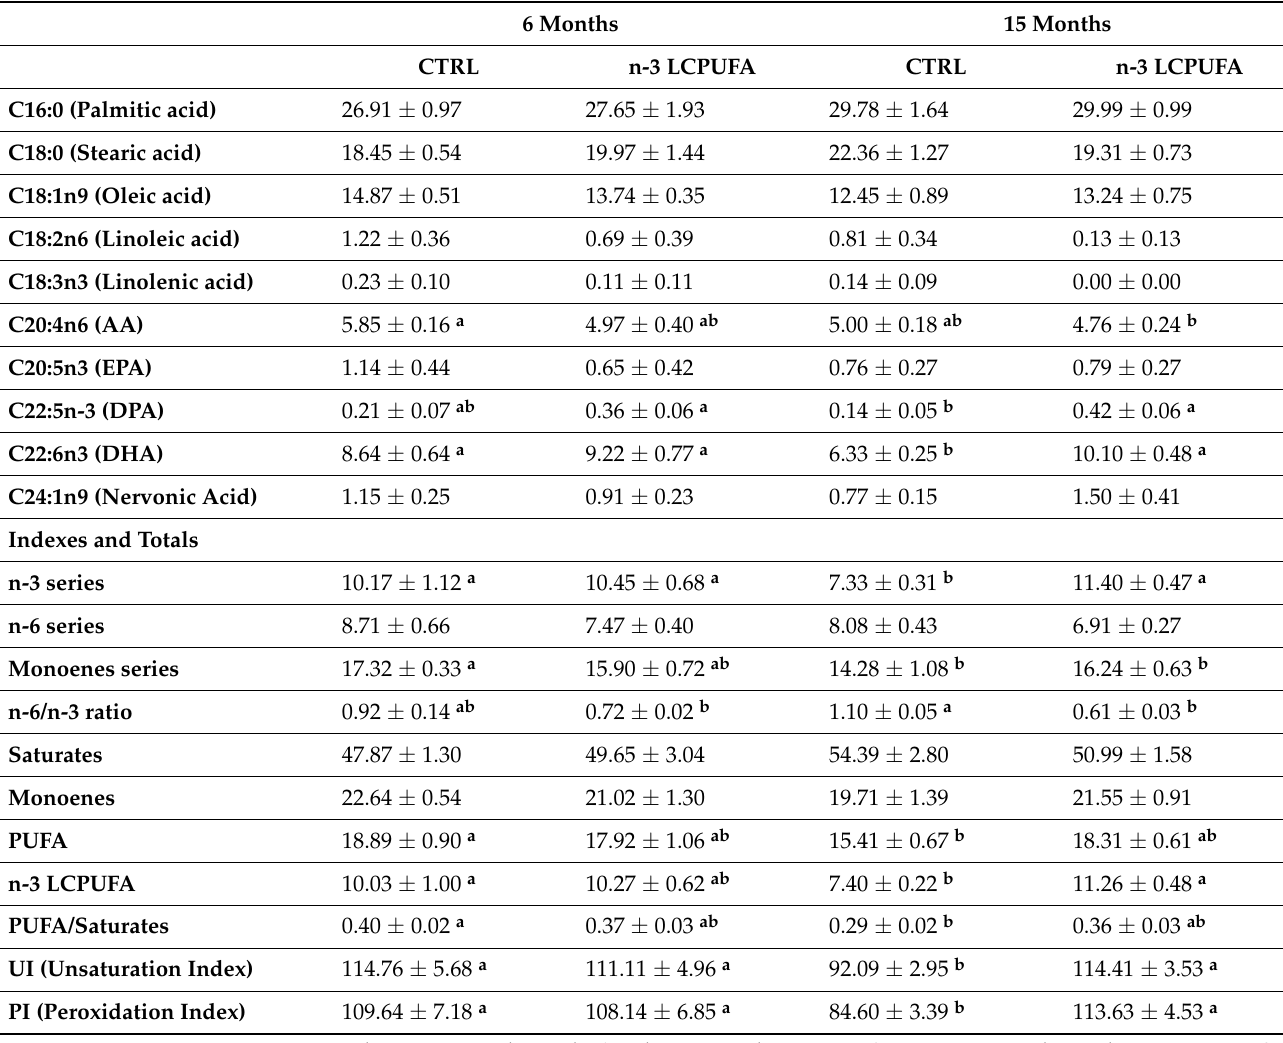
Table 1. Fatty composition of lipid rafts isolated from